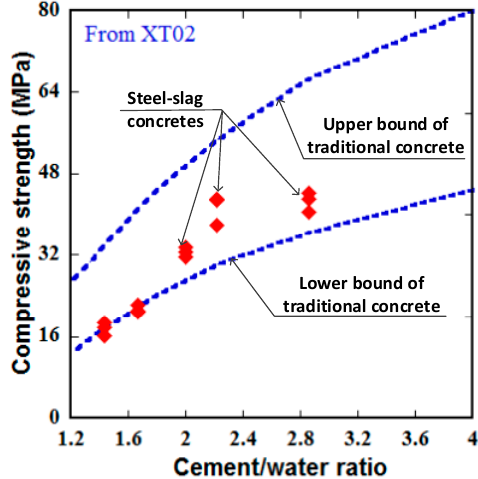
Figure 15. E ff ect of cement / water ratio on slump and compressive strength of the steel-slag concretes at Figure 15. Effect of cement/water ratio on slump and compressive strength of the steel-slag concretes Materials 2020 , 4, x FOR PEER REVIEW the 28-day age using cube specimens of 100 × 100 × 100 mm. at the 28-day age using cube specimens of 100 × 100 × 100 mm.